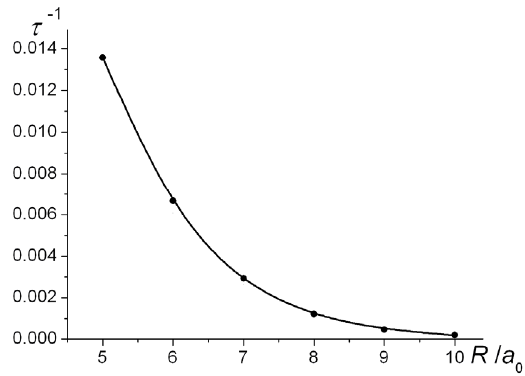
Figure 11. Computed electron transfer rates (from Equation 26) as a function of the internuclear separation.